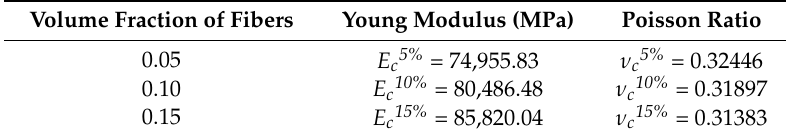
Table 2. Elastic properties of composites with three different volume fractions of fibers.